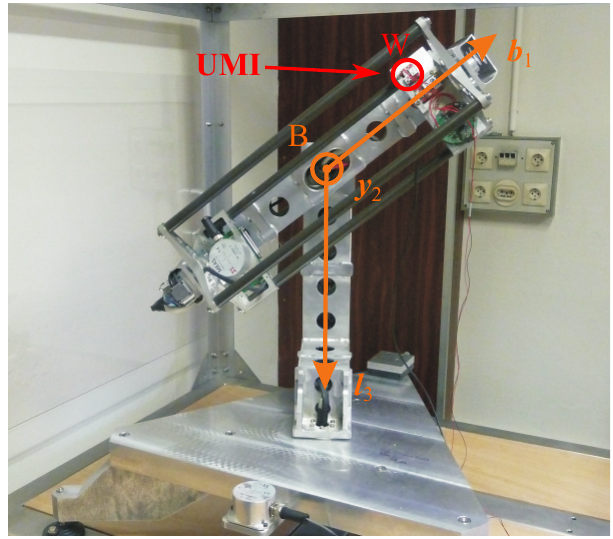
Figure 5. Test bed: three-axis table.